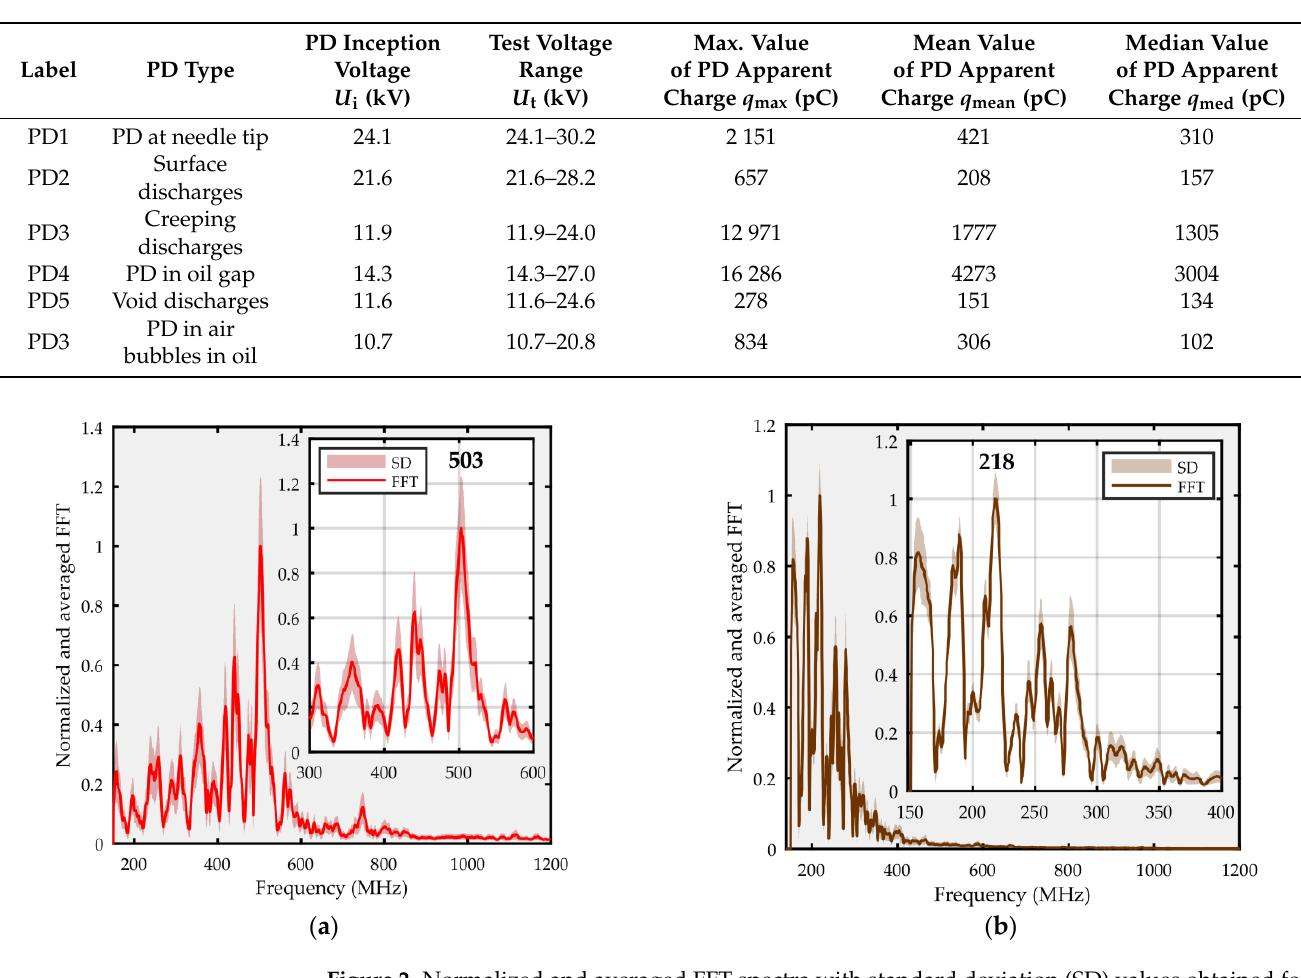
Figure 2. Normalized and averaged FFT spectra with standard deviation (SD) values obtained for ( a ) surface discharges on pressboard sample in oil with a negligibly small normal component of the electric field; ( b ) PDs in air bubbles in mineral oil. Table 3. Frequency parameters of the investigated types of